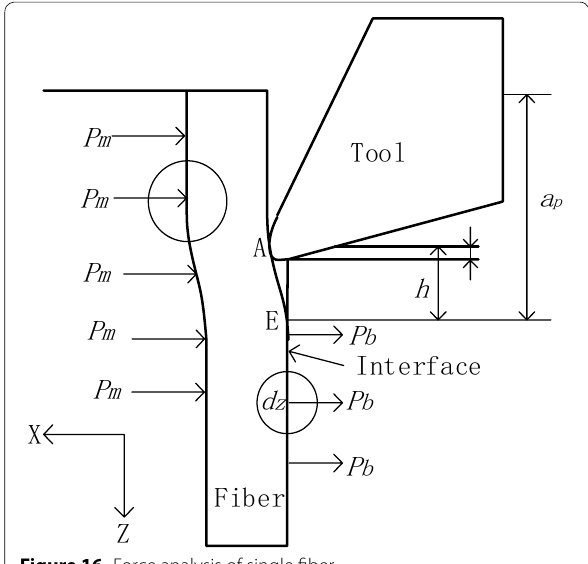
Figure 16 Force analysis of single